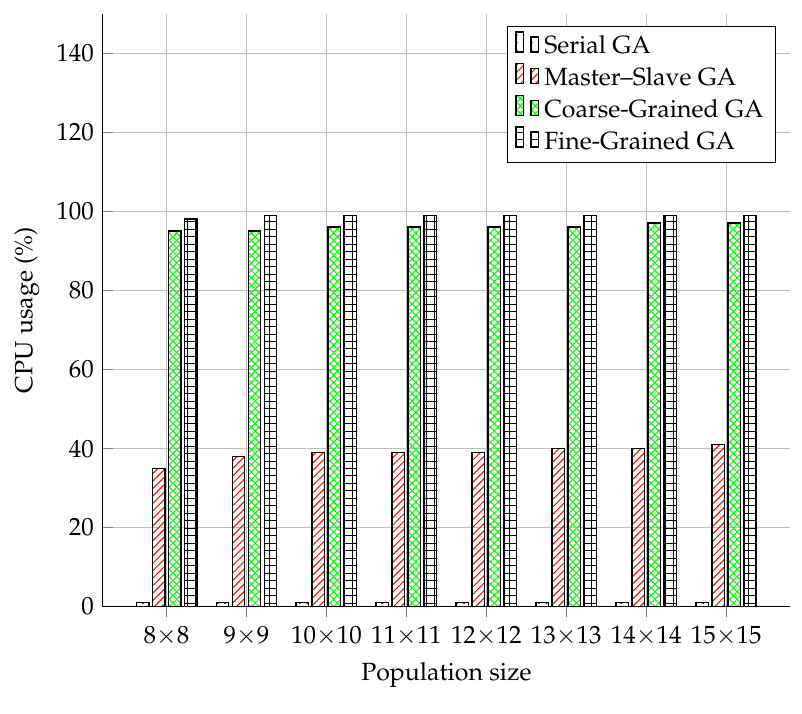
Figure 8. Comparison of GA models by CPU usage.